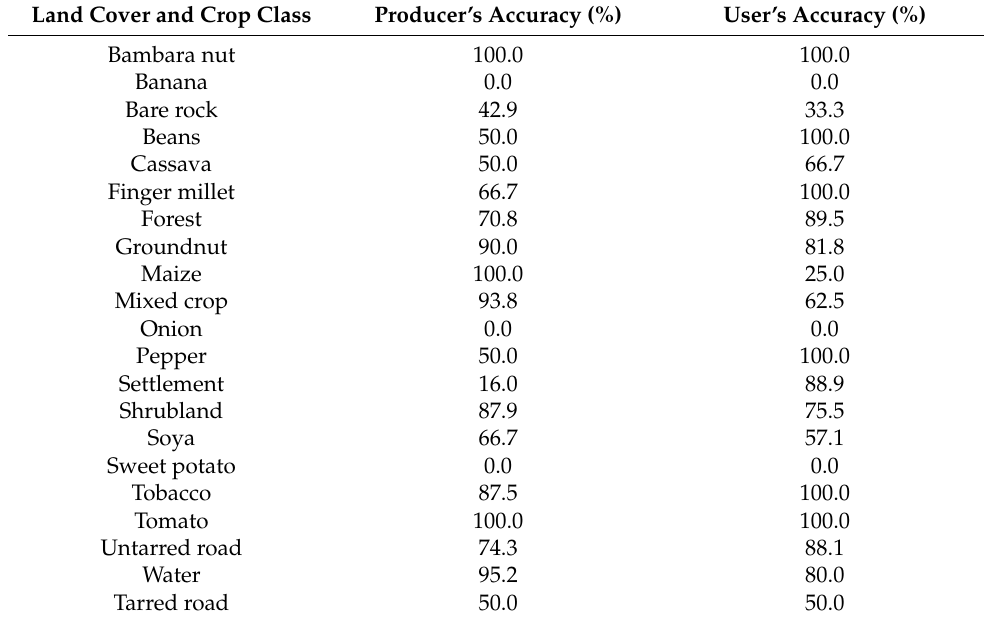
Table 5. Summary of classification accuracies of Thimalala using the fused image of Sentinel-2 and PlanetScope, Sentinel-1 C 2 matrix, and H/ α polarimetric